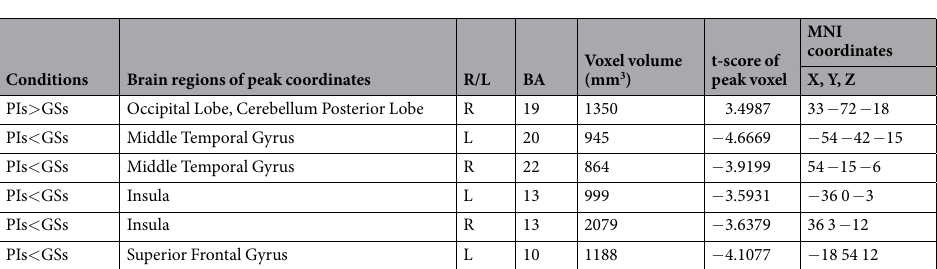
including the left temporal lobe and left inferior parietal lobule (Table 4, Fig. 7A). The left middle temporal gyrus in the executive control network showed decreased functional connectivity with the left cluster of the middle